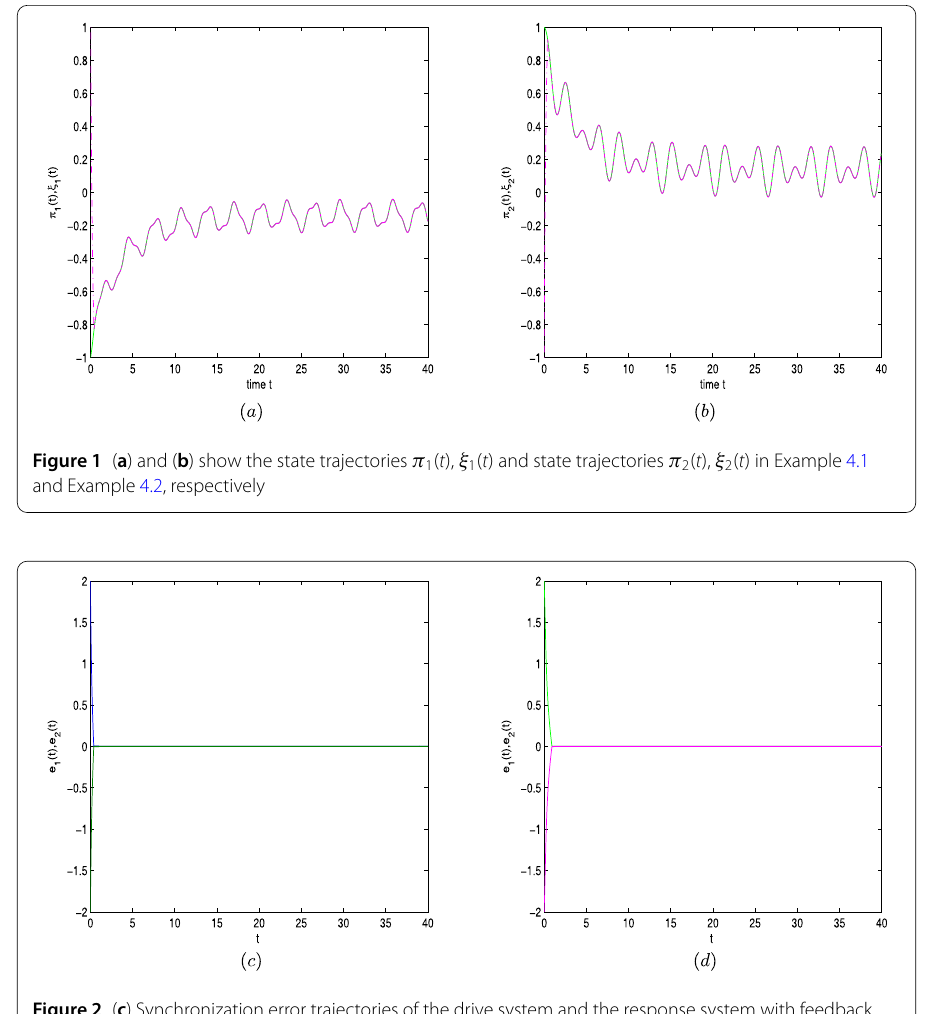
Figure 2 ( c ) Synchronization error trajectories of the drive system and the response system with feedback controller can be achieved in finite-time in Example 4.1; ( d ) Synchronization error trajectories of the drive system and the response system with adaptive controller can be achieved in finite-time in Example